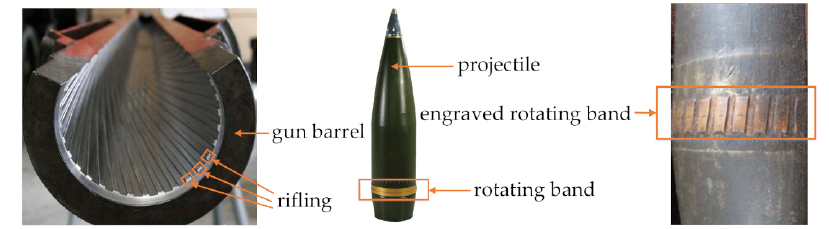
Figure 2. Exhibition of physical pictures of the gun engraving system.